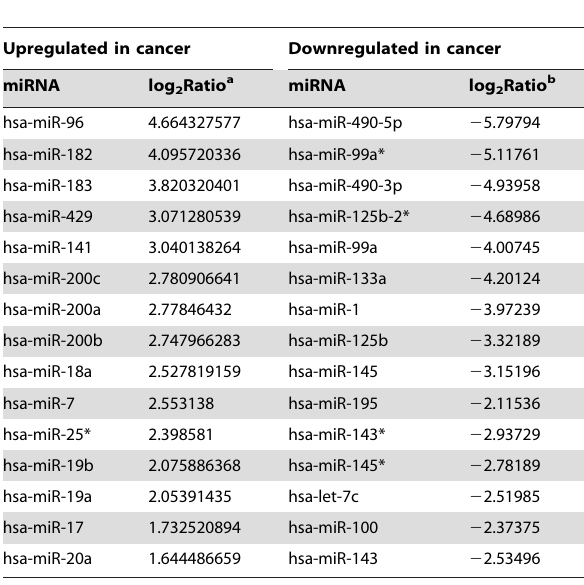
Table 1. A collection of deregulated miRNAs detected by deep sequencing in nine bladder carcinoma patients.